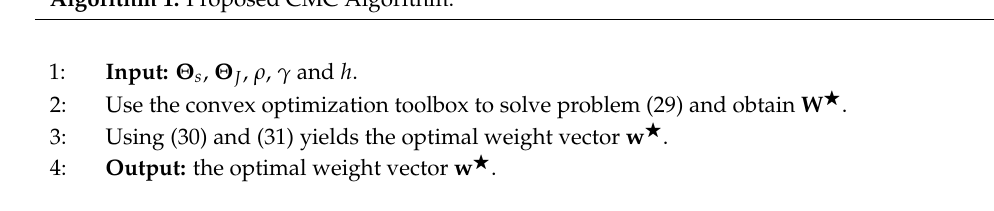
Algorithm 1: Proposed CMC